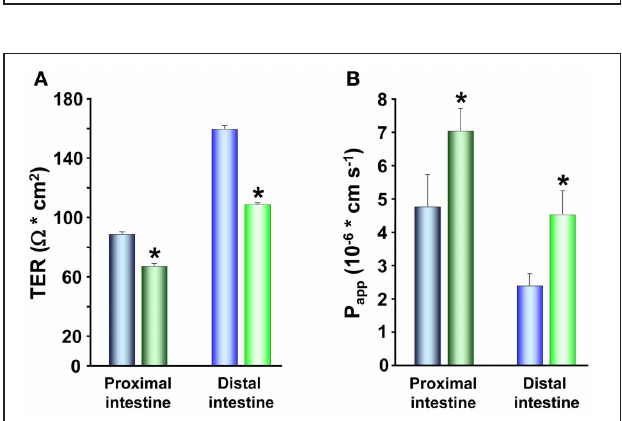
FIGURE 6 | Transepithelial resistance (TER; A) and the apparent permeability coefficients (P app ; B) of 14 C-mannitol, MW:184, in proximal and distal intestine of control ( , ) and cortisol ( , ) implanted rainbow trout acclimated to fresh water. Values presented are means ± SEM ( n = 8). Asterisks indicate significant differences between cortisol treated and control trout, in each region of the intestinal tract. All data are expressed as mean values ± SEM. Differences in the parameters measured are analyzed using Two-Way ANOVA of variance, followed by Student Neuman Keuls post hoc procedure. Significance was accepted at p < 0 . 05 (see Sundell et al., 2003; Jutfelt et al., 2007; Sundh et al.,